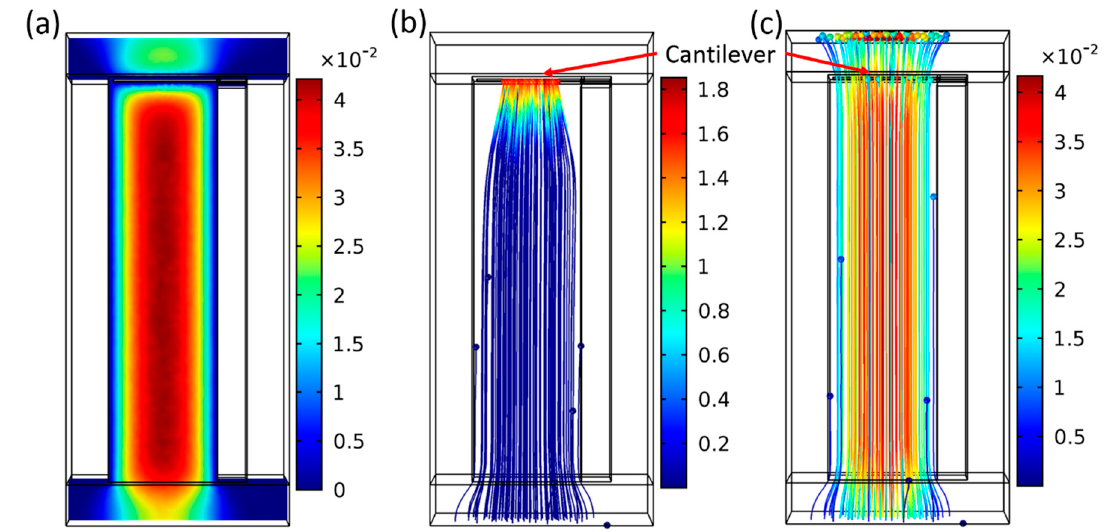
Figure 8. Photograph and SEM images of a cantilever resonator inside a custom-built sampler and with electrostatically collected NPs, respectively.